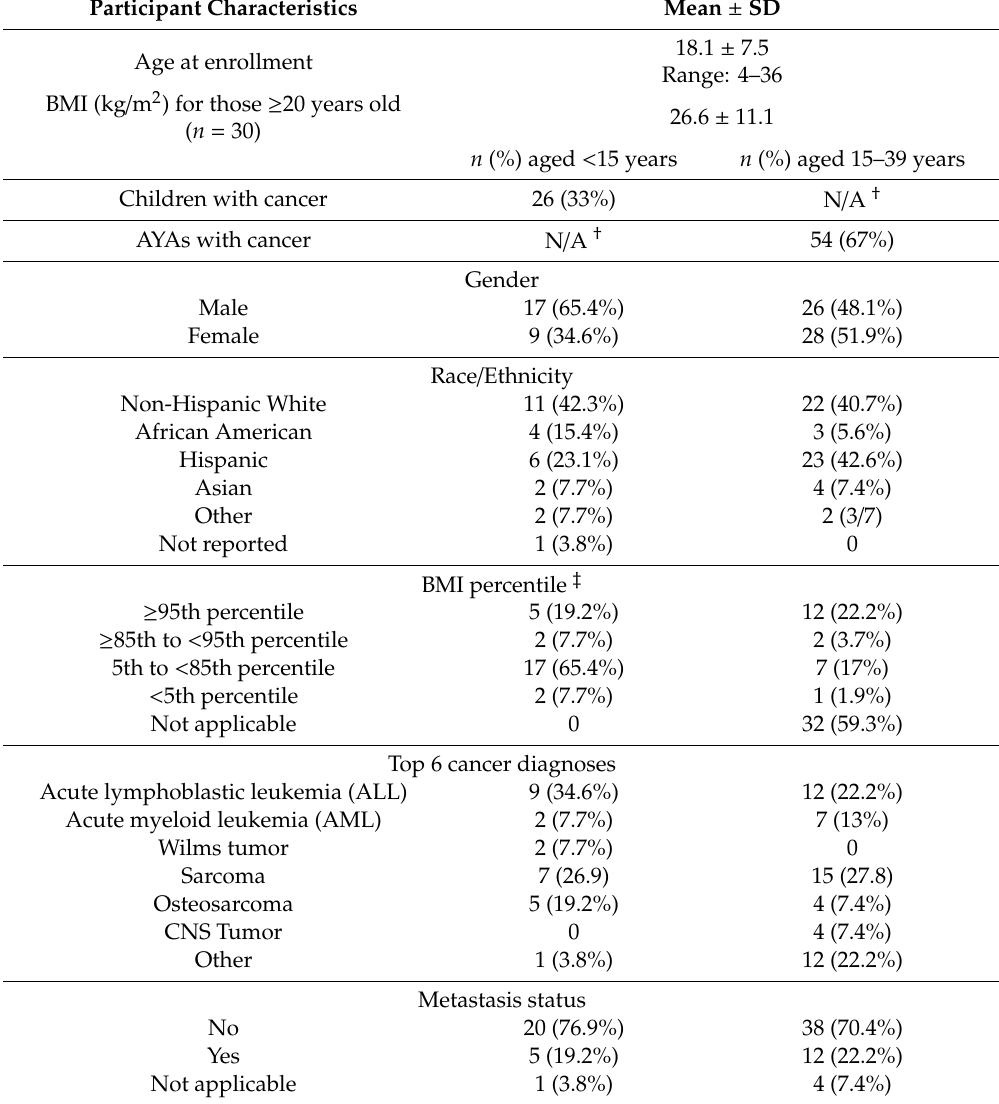
Table 2. Summary of study participant characteristics ( n =